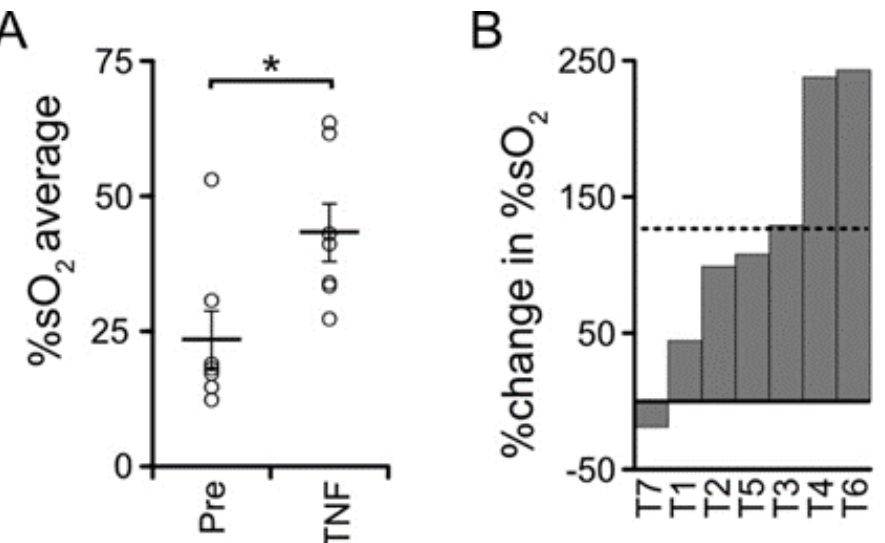
Figure 6. TNF in the absence of castration is insufficient to induce intra-tumoral hypoxia in Myc-CaP tumors. ( A ) Large bars, mean PAI signal (%sO 2 ) from tumors pre-castration (n = 7), and at one day following TNF treatment (n = 7). PAI signals from individual tumors (open circles) and SEM (small bars). * p < 0.05. ( B ) Waterfall plot of %change in %sO 2 in individual tumors (columns) after TNF treatment. Mean %change is dashed line.